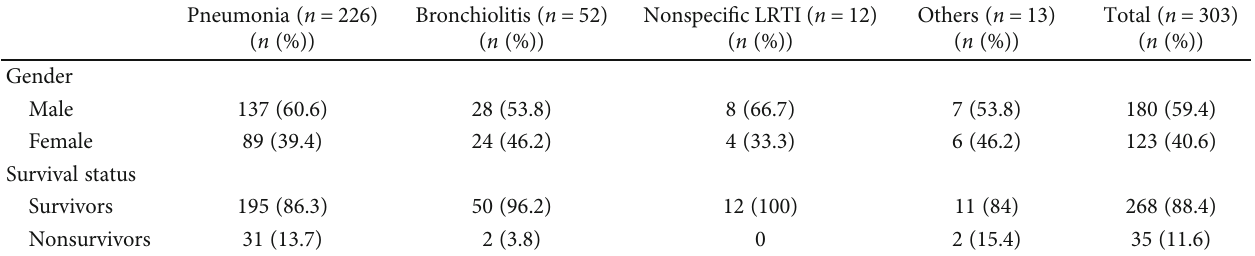
Table 3: Distribution of diseases based on the gender and survival of pediatric patients ( n = 303 ).